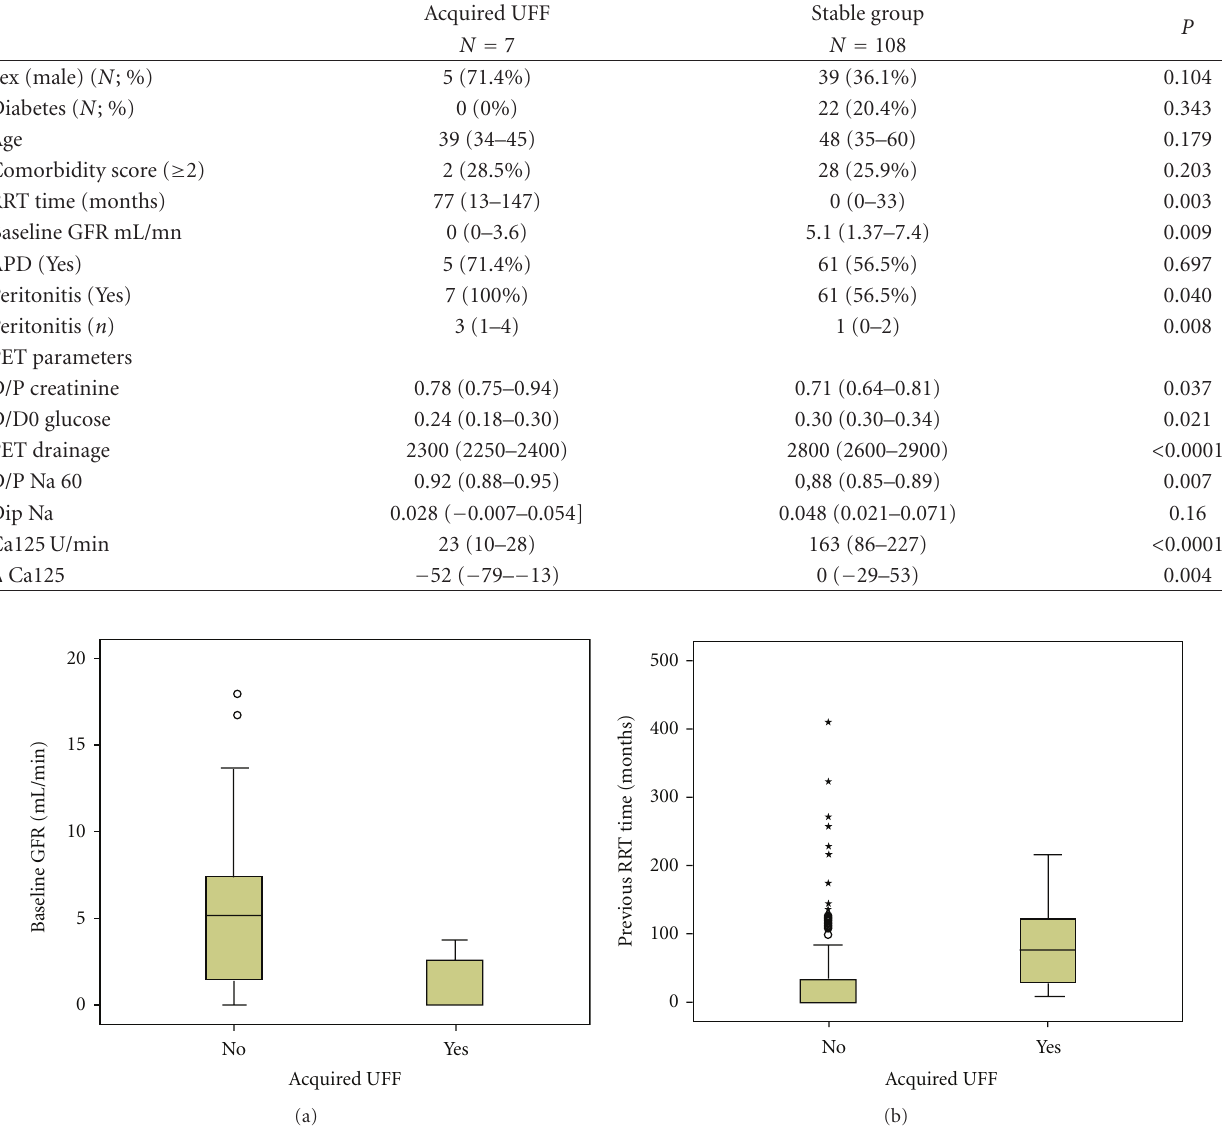
Figure 3: Comparison between acquired UFF patients and preserved UF group: acquired UFF group had significantly lower baseline residual renal function ( P = 0 . 009) and longer previous renal replacement therapy ( P = 0 .